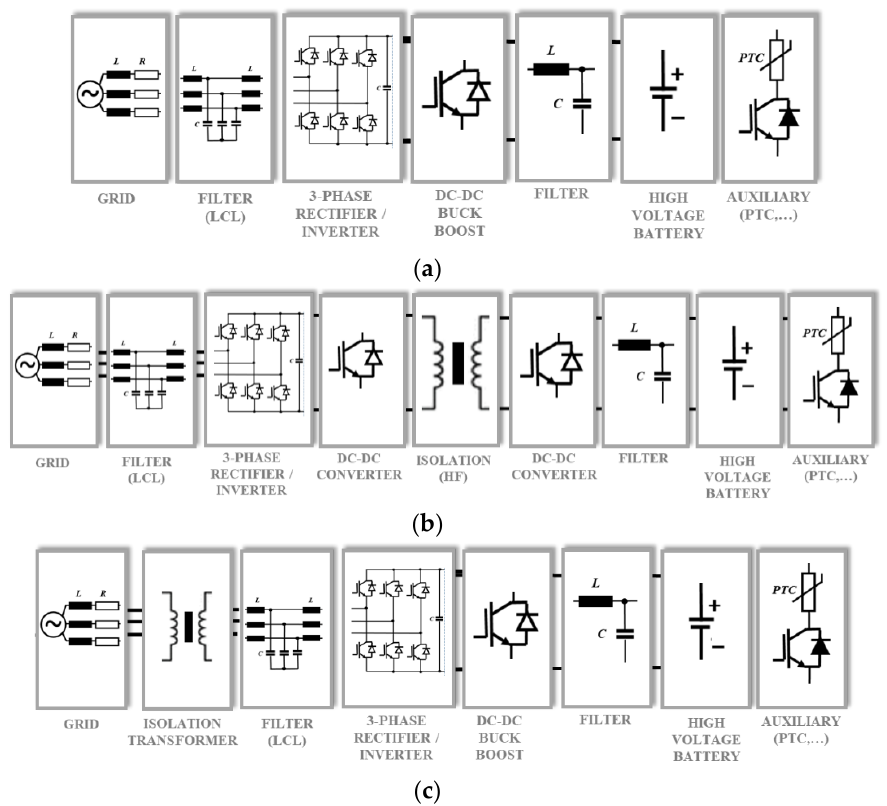
Figure 1. Topologies of bi-directional EVSE. ( a ) Non-isolated bi-directional EVSE; ( b ) DC-Isolated bi-directional EVSE using a HF-transformer; ( c ) AC-Isolated bi-directional EVSE using an isolation transformer.